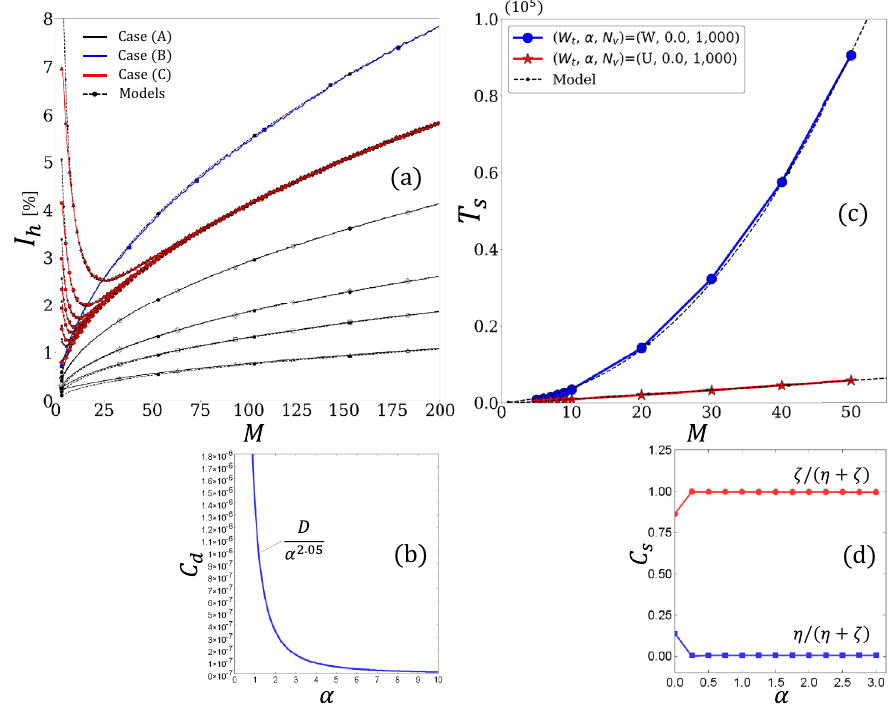
Figure 6. ( a ) Comparison of our models with the simulation results in cases of (A), (B), and (C) in Fig. 4 in Scenario-1, ( b ) dependence of parameter C d on parameter α , ( c ) comparison of our models with the simulation results in two cases of uniform preferences and the weighted preferences with α dependence of parameter C s on parameter α